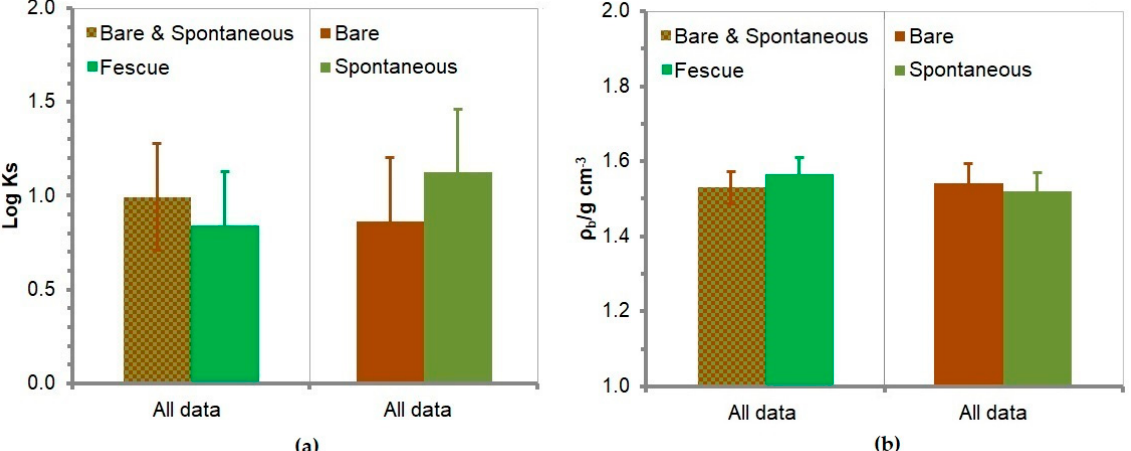
Figure 4. ( a ) Logarithm to base 10 of the soil surface saturated hydraulic conductivity ( K s) in the different treatments alongside the 95% confidence interval for the means according to the orthogonal contrasts based on the two-way ANOVA results; ( b ) bulk density ( ρ b ) at 0–5 cm in the different treatments alongside the 95% confidence interval for the means according to the orthogonal contrasts based on the two-way ANOVA results.